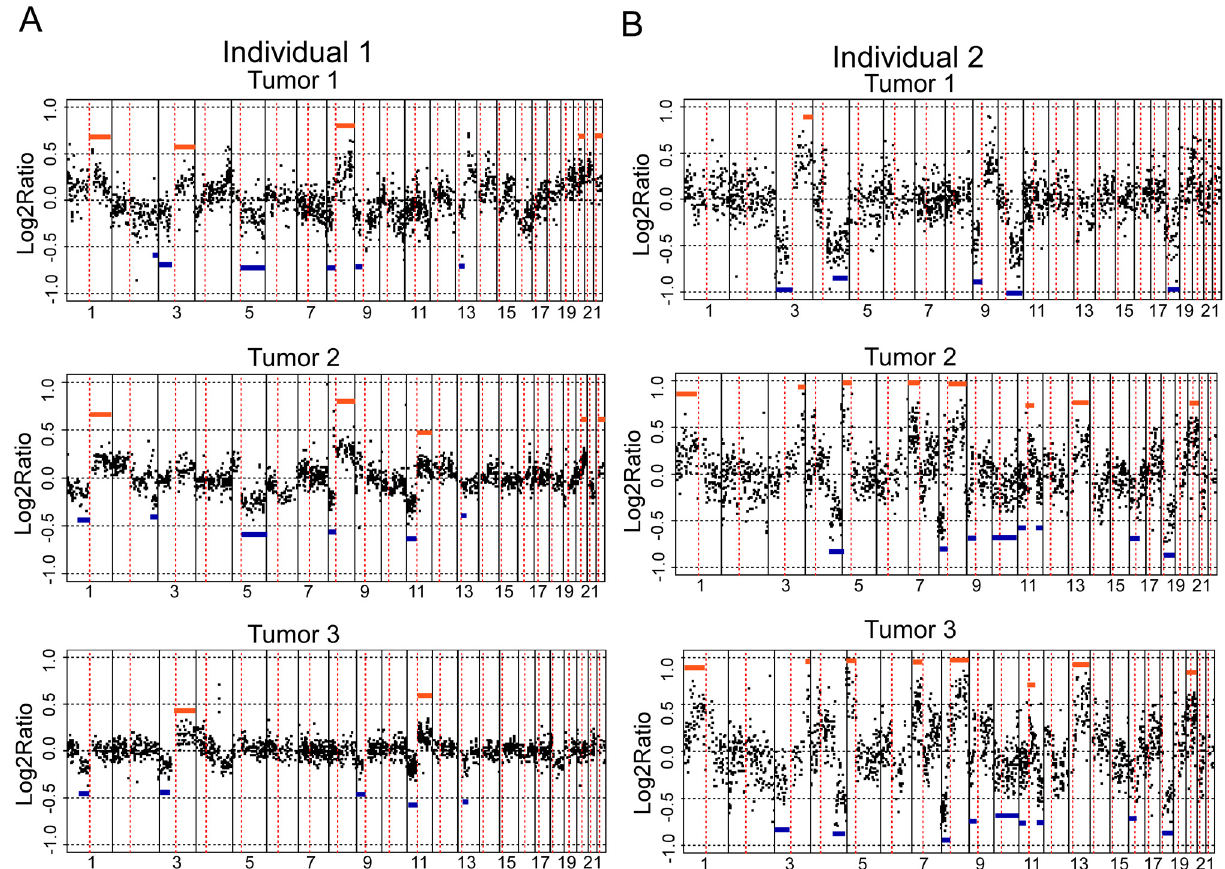
Figure 2. aCGH profiles of independent tumors from two individuals. aCGH profiles of three independent tumors from two individuals, A and B, are shown. Each dot represents a different BAC clone. The X-axis for each profile shows the BAC clones ordered from chromosomes 1 through 22. Chromosome boundaries are indicated by vertical lines and dotted lines indicate centromeres. The Y-axis is the log2ratio of the tumor genomic DNA compared to reference DNA. Blue lines indicate regions showing concordance for loss and orange lines indicate regions showing concordance for gain across tumors.